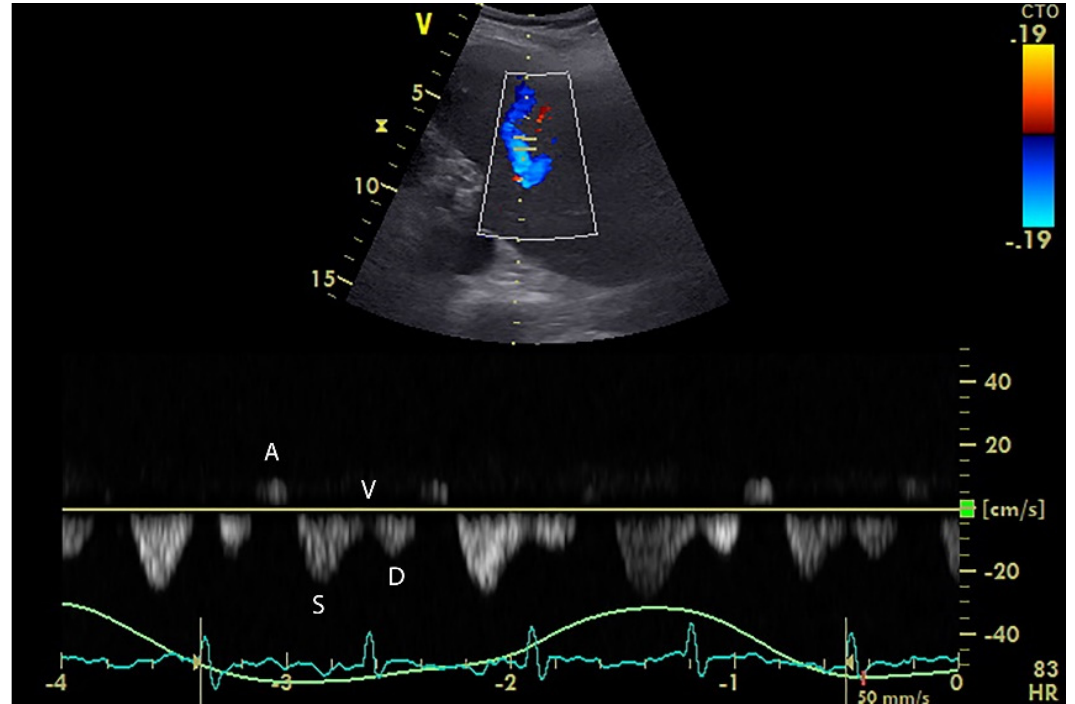
Figure 4. Spectral Doppler waveform in the middle hepatic vein (MHV) of a ventilated patient. In a prospective study with 44 mechanically ventilated patients in septic shock, HVF was evaluated from subcostal echocardiographic views by first scanning the IVC and then